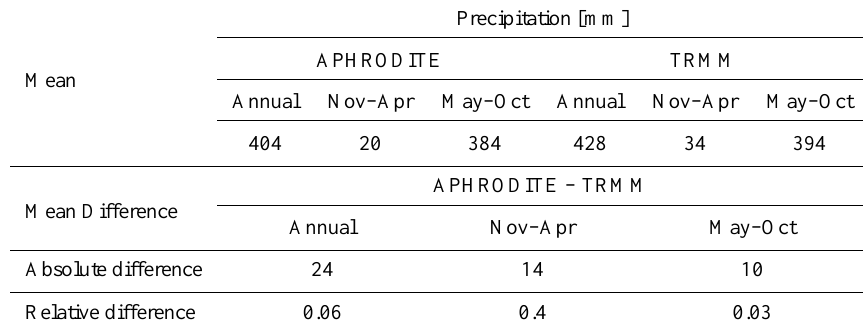
Table 7. Statistical analysis results for precipitation data of APHRODITE and TRMM for the period